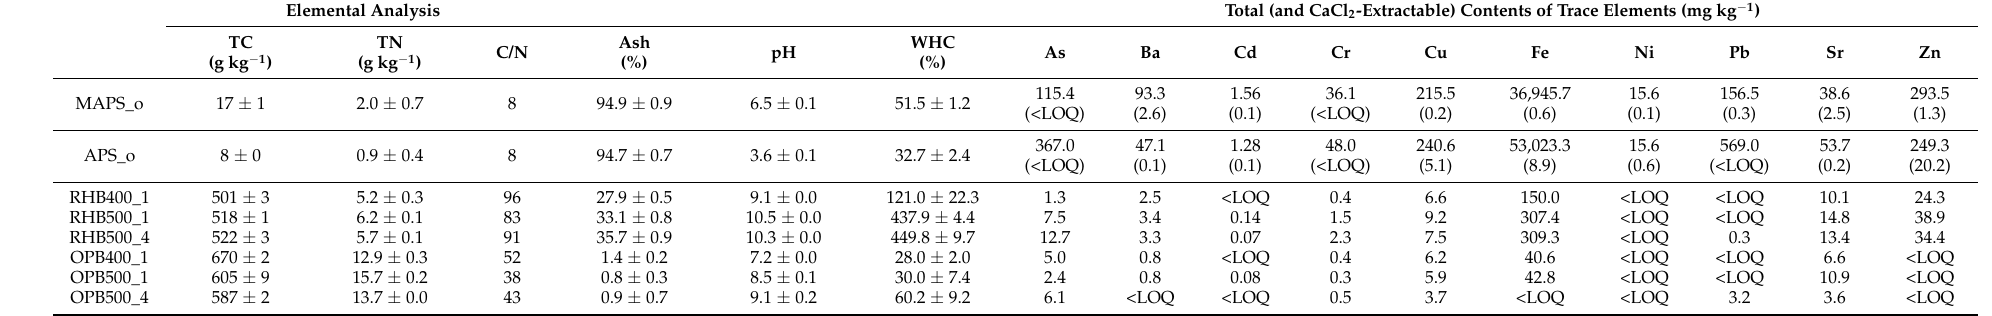
Table 1. Elemental analysis, physical and chemical properties and contents in trace elements of the two studied soils and of the six biochars used for the incubation experiment. Elemental